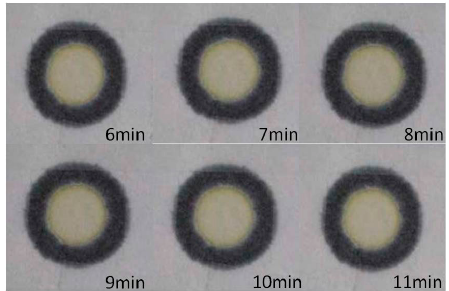
Figure 4. The color changes with reaction time for the AST reagent and human serum.